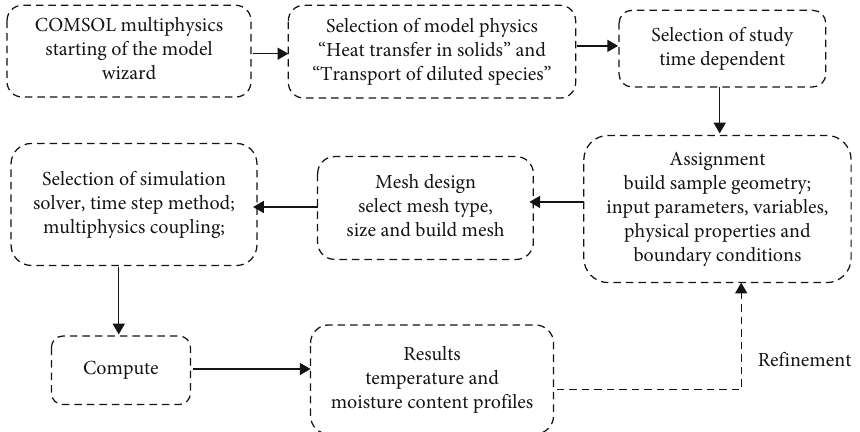
Figure 4: Flow chart for implementation of the coupled heat and mass transfer model and simulation procedure using COMSOL [12, 39].